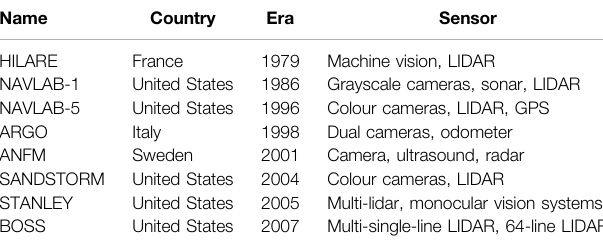
TABLE 1 | Sensors used in unmanned intelligent vehicles.